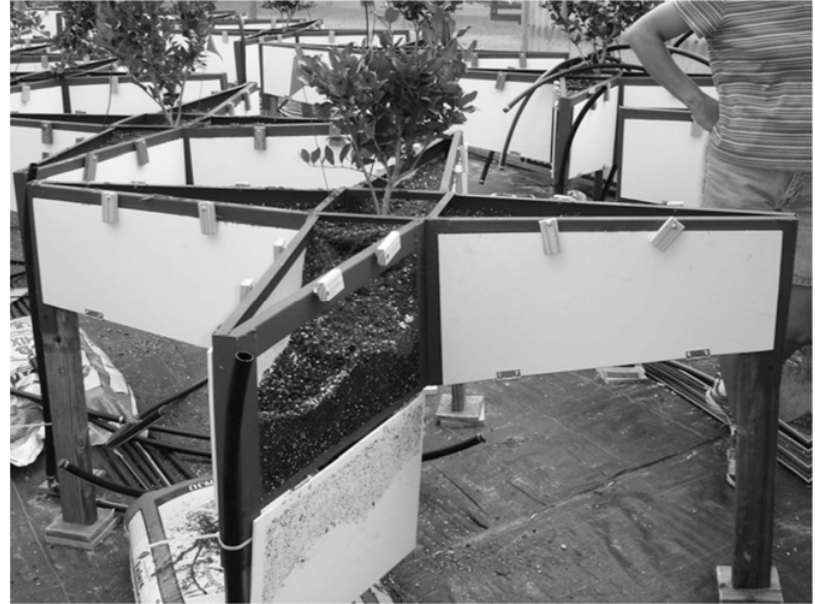
Figure 1. A large-volume rhizotron with a transplanted one-year-old Ligustrum japonicum ; the window is open for demonstration of viewable rhizosphere (original picture by Silva and Beeson